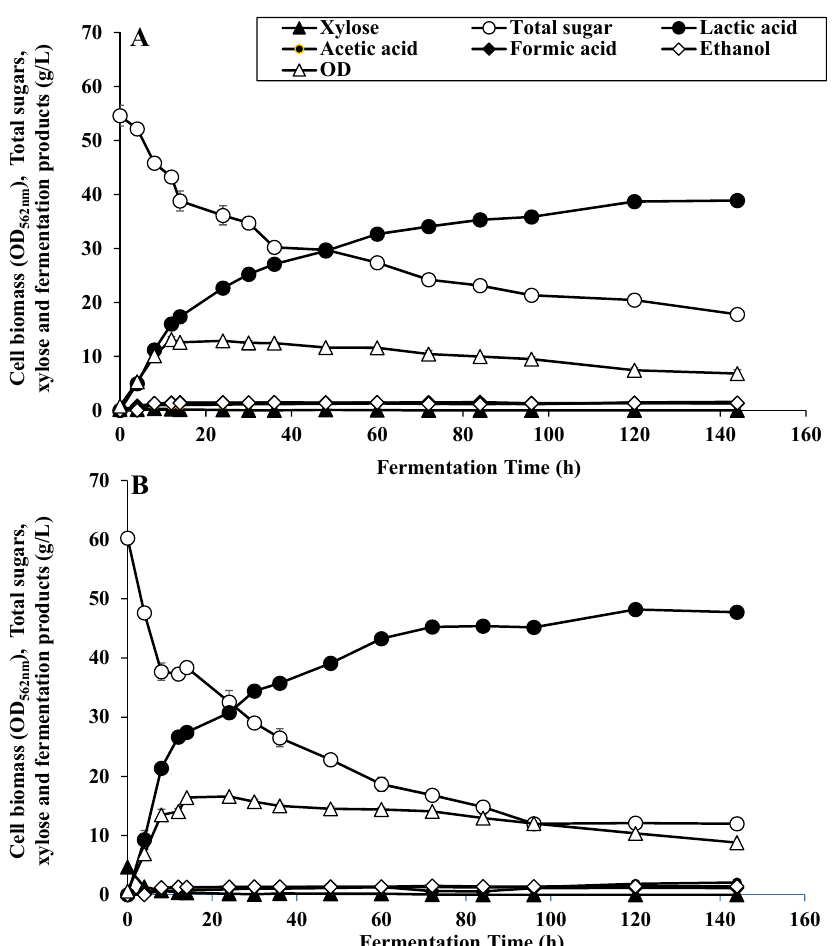
Figure 4. Lactic acid fermentation of xylooligosaccharides mixture ( A ), and xylose/xylooligosaccharides mixture ( B ) by E. faecium s6 at controlled pH 6.5 and 45 °C. In order to enhance XOS utilization, fermentation of 50 g/L of XOS plus 5 g/L xylose was investigated. As expected, higher biomass was obtained with OD 562 nm at 16.6 after 24 h of fermentation. Consequently, high sugar concentration was consumed, achieving a maximum LA production of 48.2 g/L within 120 h at a yield of 1.0 g/g -consumed sugar and productivity of 0.331 g/L.h. The maximum sugar utilization rate was enhanced, achieving a maximum LA productivity at 3.02 g/L.h as compared to 1.18 g/L.h in XOS without xylose supplementation. Few by-products were also produced of acetic acid (1.85 g/L), formic acid (1.18 g/L), and ethanol (1.41 g/L). To the best of our knowledge, the high concentra- tion of LA from XOS obtained in the present study is the first to be reported by LAB. The residual unconsumed sugars might indicate that strain s6 was unable to utilize XOS larger than xylohexaose (Figure 5C,D). Leuconostoc lactis SHO-47, Le. lactis SHO-54, and Lc lactis IO-1 produced only 2.3 g/L, 2.2 g/L, and 1.3 g/L lactic acid, respectively, from 8.5 g/L hy- drolyzed xylan [11].